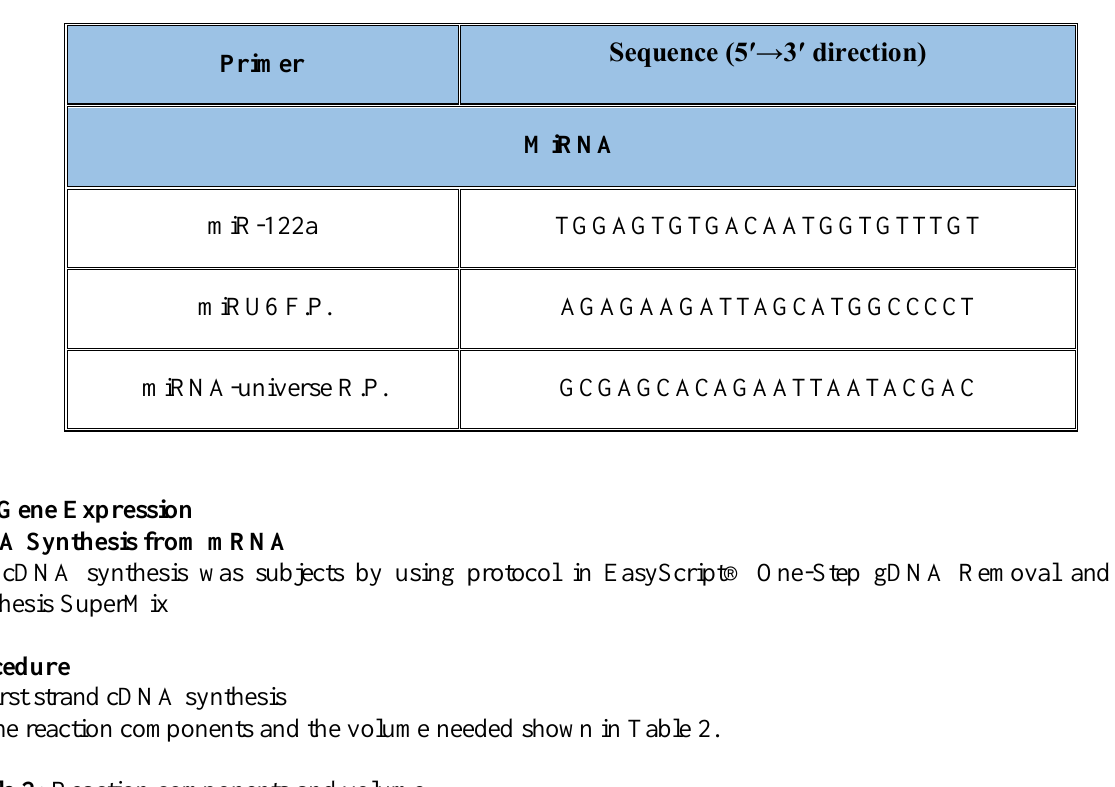
Table 2: Reaction components and volume.